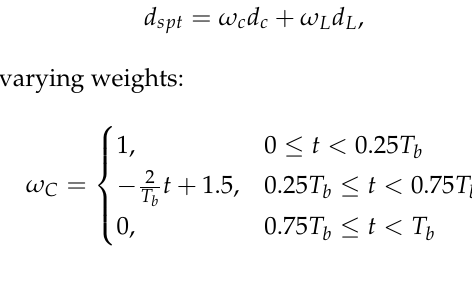
Figure 10. Distances between 𝑍𝑀𝑃 0 and the support lines ( 𝑑 𝐶 and 𝑑 𝐿 ).